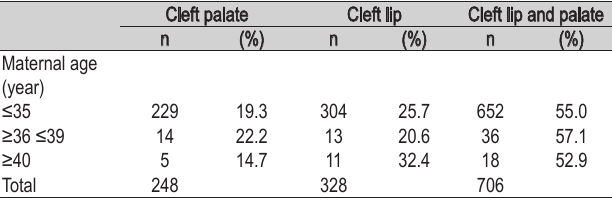
Table 2 - Distribution of non-syndromic cleft lip and/or palate according to type and maternal